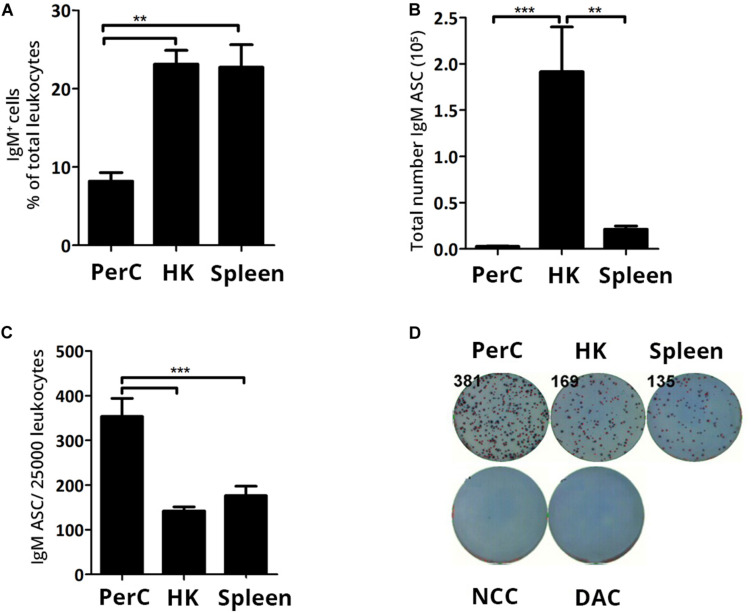
In steady state Atlantic salmon head kidney (HK) harbors the highest IgM ASC numbers of the three sites. Presence of B cells and IgM ASC were analyzed from naïve Atlantic salmon (A) IgM+ B cell frequency of total leukocytes was analyzed by flow cytometry. (B) Total IgM ASC or (C) IgM ASC per 25,000 leukocytes in PerC, HK, and spleen were analyzed by ELISpot. (D) Representative ELISpot wells. Statistical significance between tissues/sites are indicated by brackets. Asterisks indicate strength of significance: **p < 0.01 and ***p < 0.001. Data present mean + SEM from at least five individuals (n ≥ 5). NCC-No cell control; DAC, detection biotinylated antibody control.